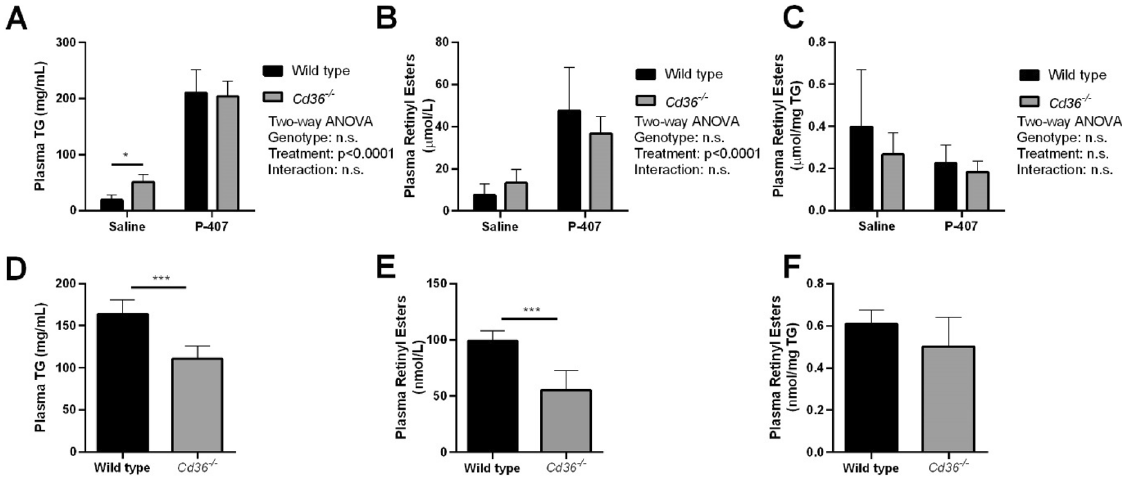
Figure 5. Circulating triglyceride and retinyl ester metabolism in wild type and Cd36 −/− mice. Postprandial ( A ) plasma triglyceride and ( B ) plasma retinyl ester clearance was determined in saline and p-407 injected mice. ( C ) Retinyl esters were also normalized to plasma TG (WT Saline, n = 7; Cd36 −/− Saline, n = 6; WT p-407, n = 7; Cd36 −/− p-407, n = 5 mice per group). Hepatic VLDL D) triglyceride secretion and ( E ) retinyl